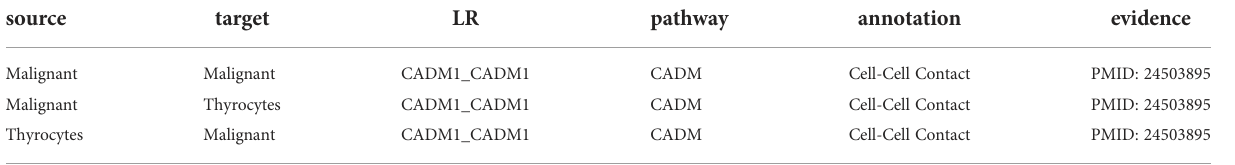
TABLE 3 Information of pathways involved in